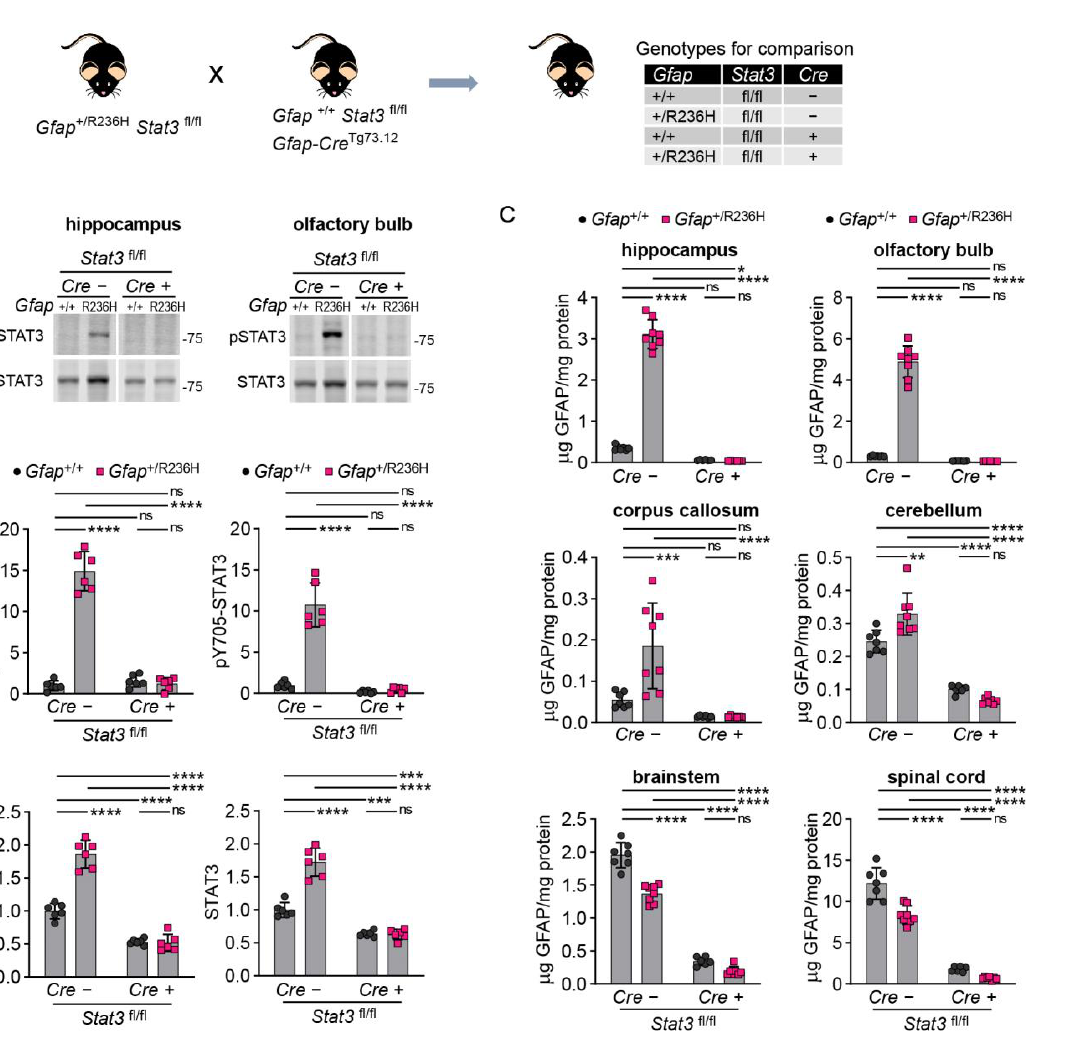
Figure 4. GFAP protein in AxD model mice with conditional genetic knockout of Stat3 in Gfap expressing cells at 12 weeks of age. ( A ) Genetic cross to generate Gfap +/R236H mice and Gfap +/+ littermate controls with both Stat3 alleles floxed (fl/fl) and a Gfap -promoter-driven Cre transgene (Tg73.12). ( B , C ) Quantitation of pY705-STAT3 and total STAT3 protein in olfactory bulb and hippocampus by immunoblotting ( B ), and GFAP protein in multiple brain regions and cervical spinal cord by ELISA ( C ). Values in ( B ) are normalized to total protein and represent fold change relative to the average for Gfap +/+ ; Stat3 fl/fl ; Cre (-) mice. C57BL/6J males and females, two- way ANOVA with Sidak’s post -